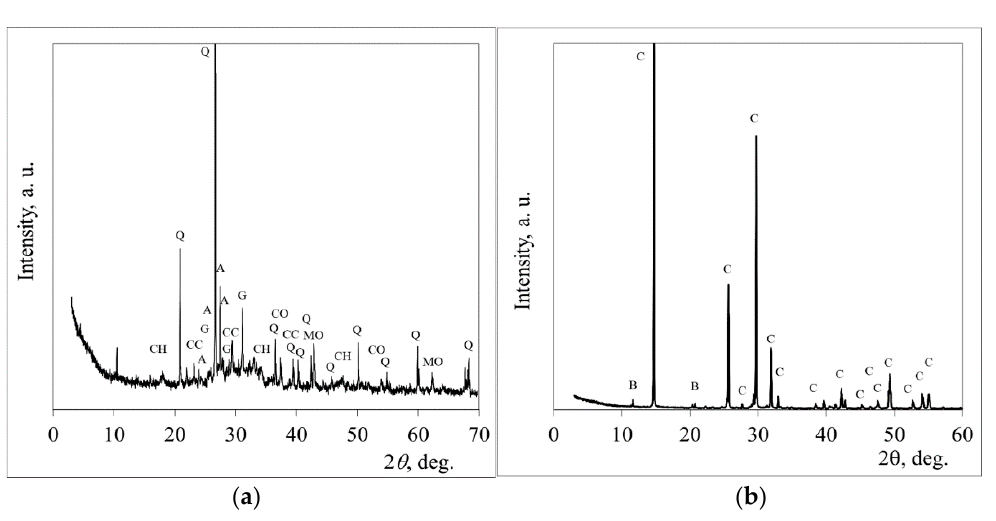
Figure 3. The mineral composition (XRD analysis) of ( a ) biomass bottom ash and ( b ) phosphogypsum.